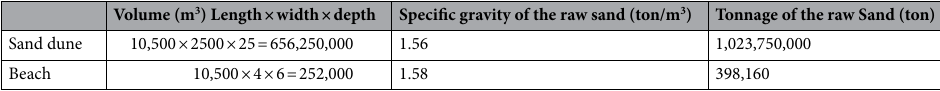
Table 7. The tonnage of the raw sand of the studied